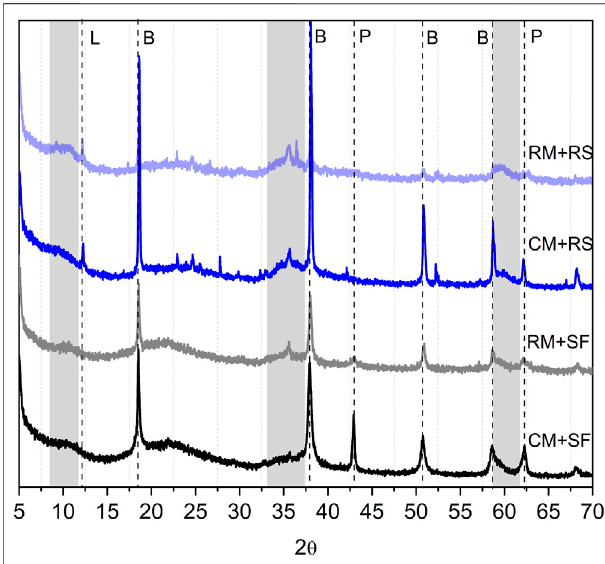
FIGURE 3 | XRD patterns of 7 days hydrated samples (P: Periclase, B: Brucite, L: Lizardite, grey bands correspond to M-S-H).